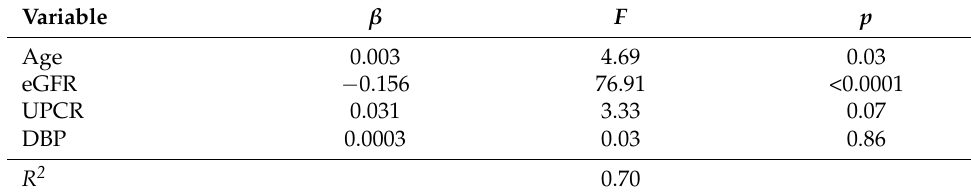
Table 3. Stepwise multiple regression analysis of factors associated with EphA2.